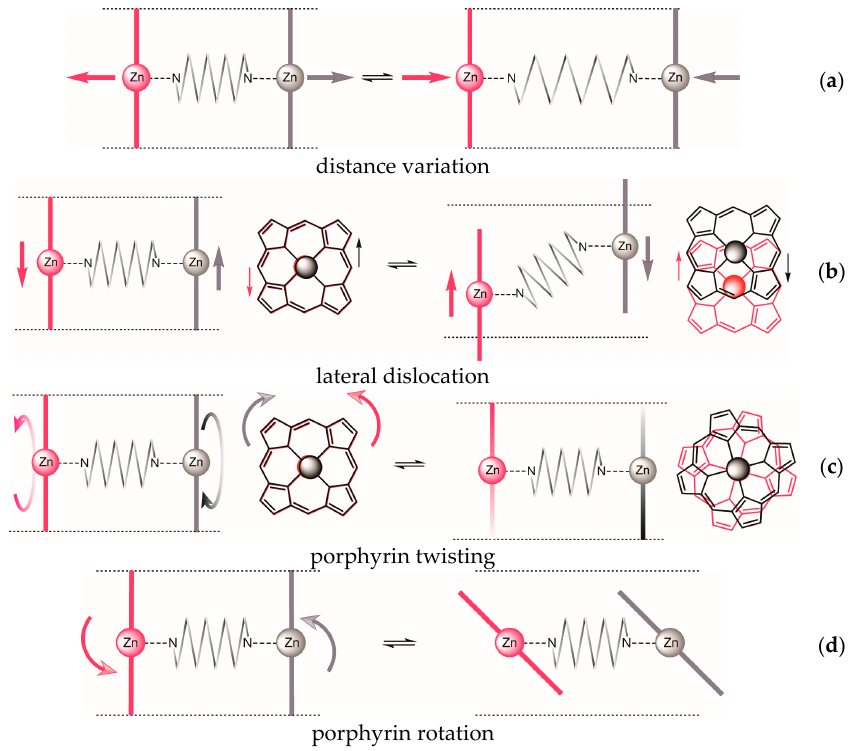
Figure 2. Possible dislocations in bisporphyrin tweezers: ( a ) Variation of interporphyrin distance; ( b ) lateral displacement; ( c ) porphyrin twisting; ( d ) porphyrin rotation. Table 1. Porphyrin dislocation modes (Figure 2) in bisporphyrin tweezers 1 – 3 a .